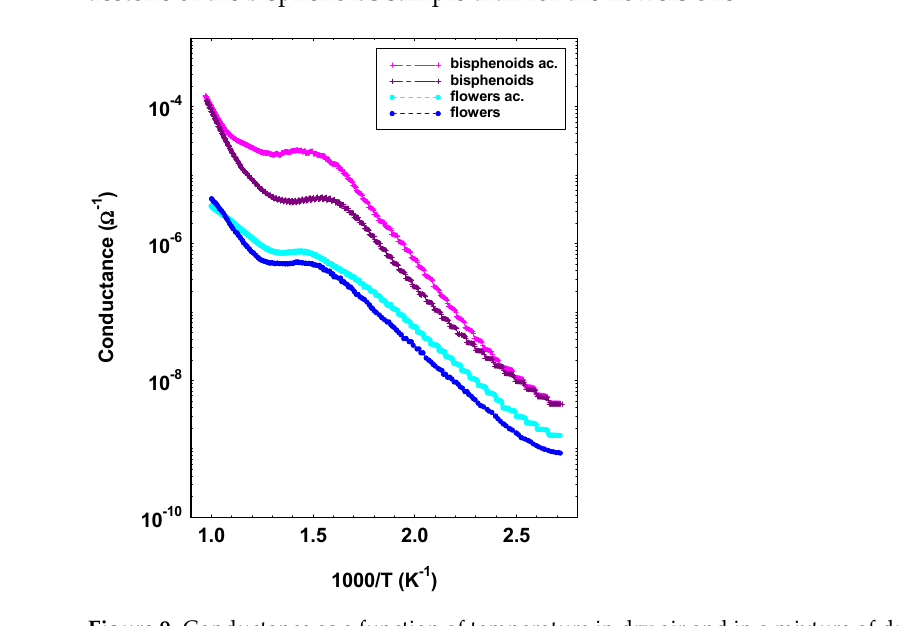
Figure 9. Conductance as a function of temperature in dry air and in a mixture of dry air and acetone (10 ppm) for bisphenoids and flowers sensors.